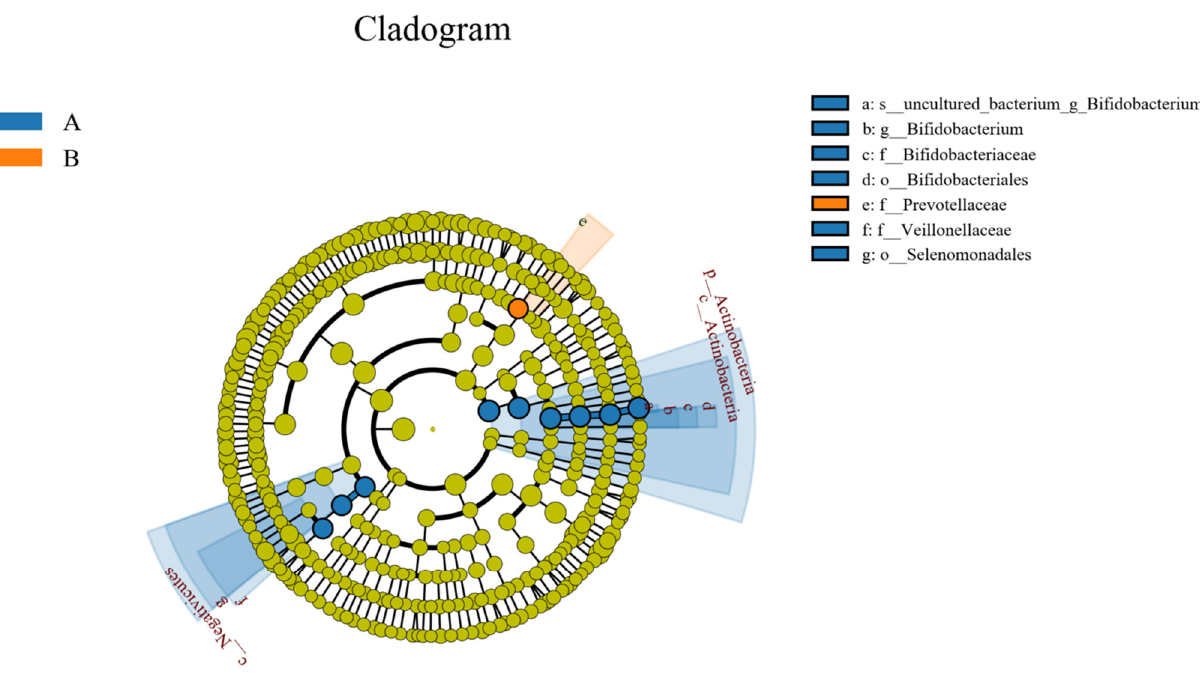
Figure 23. Evolutionary branch map of intestinal flora LefSe. A represents the control group; B represents the study